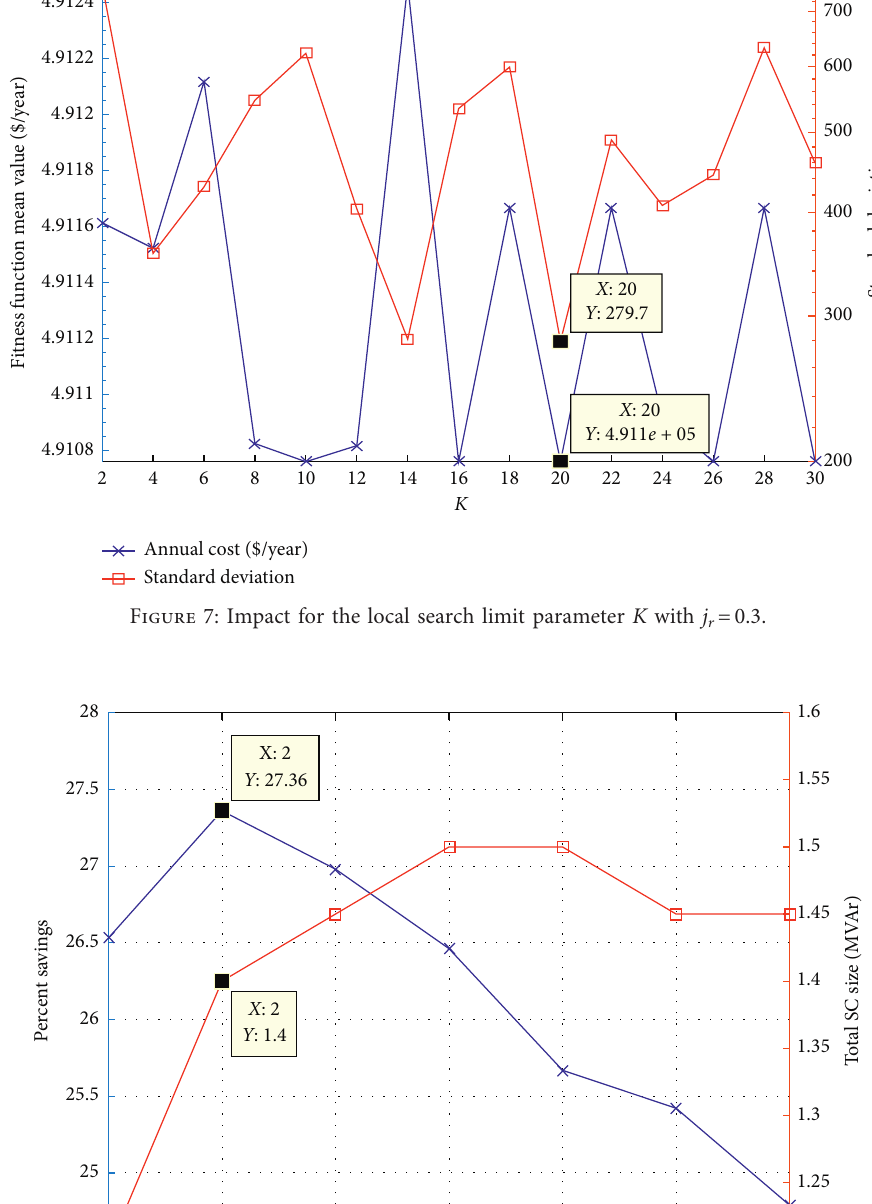
Figure 8: Effect of different numbers of SCs on performance of 69-bus